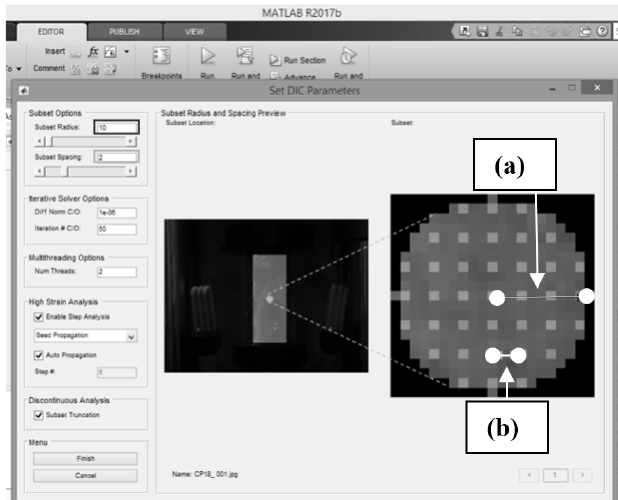
Figure 3: subsets of the region of interest (a) radius of the subset 10 pixels, (b) spacing of the subset 2 pixels [11]